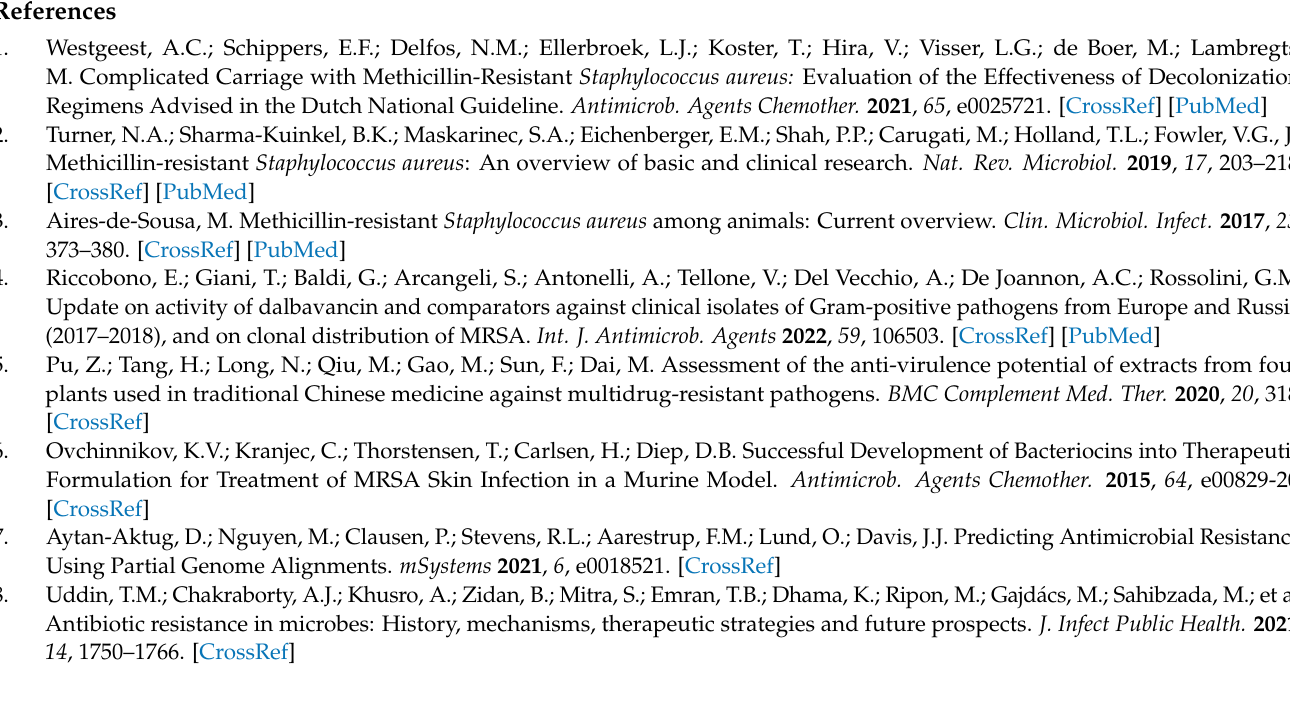
Figure A1. Development of resistance to SGB, linezolid, and vancomycin in ATCC 33591 ( a ) and DPS − 2 ( b ). S. aureus treated with subinhibitory concentrations of SGB was passaged for 10 genera- tions (40 days), and the MIC fold change at each cycle was measured. The data are presented as the mean ± standard deviation of the two independent experiments.